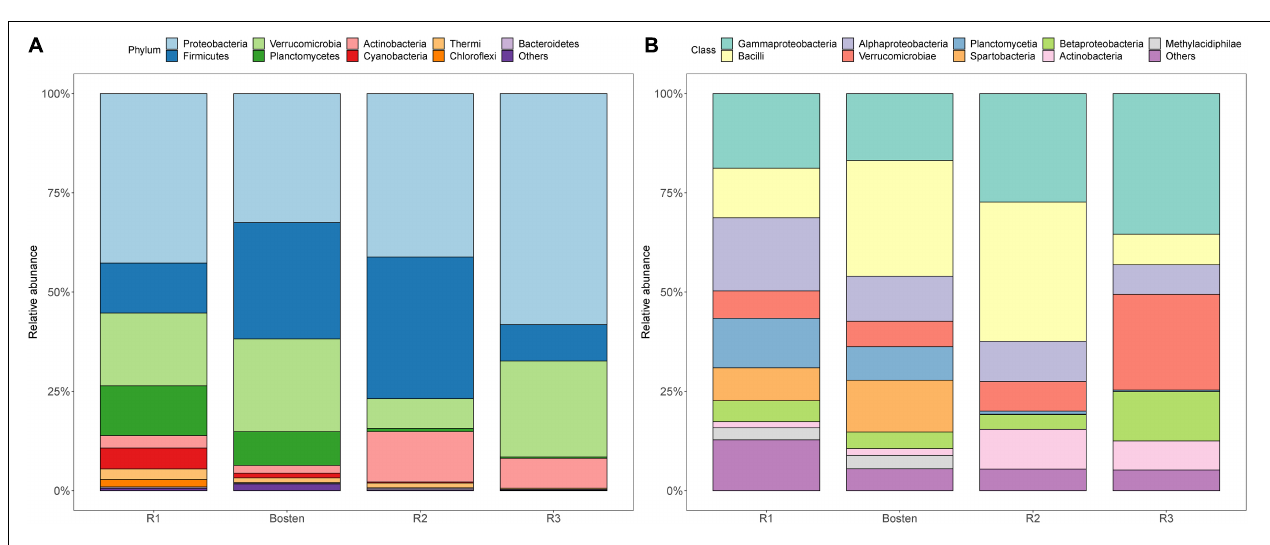
FIGURE 5 | The bacterial community compositions of four lakes at the phylum (A) and class levels (B) .